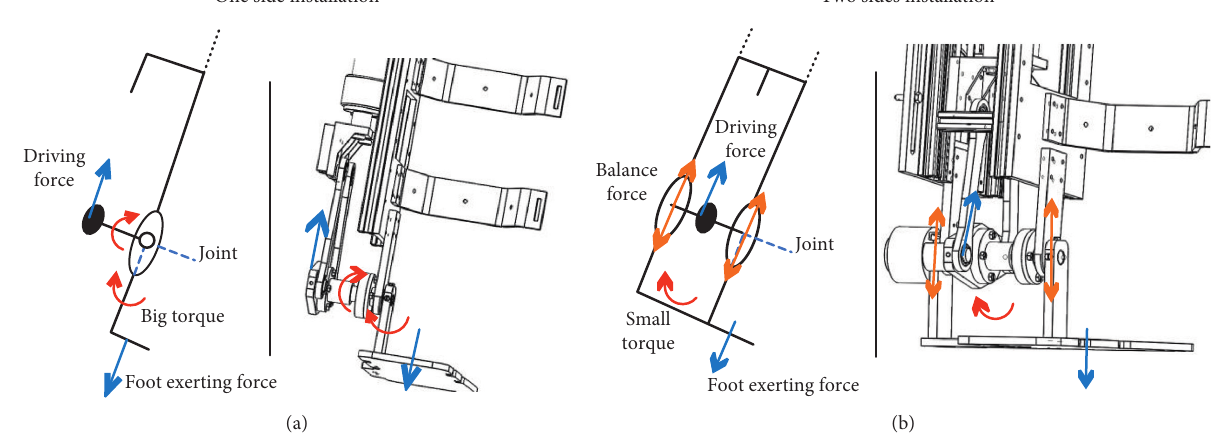
Figure 5: Comparison of two installing types of driving mechanism: (a) unilateral asymmetric structure; (b) symmetrical configuration.